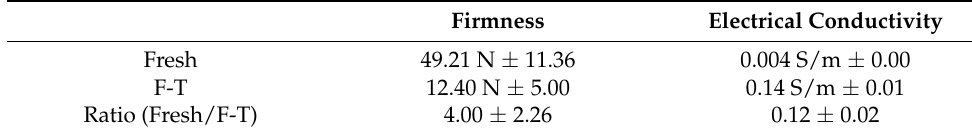
Table 4. Firmness and electrical conductivity ratio of fresh and F-T